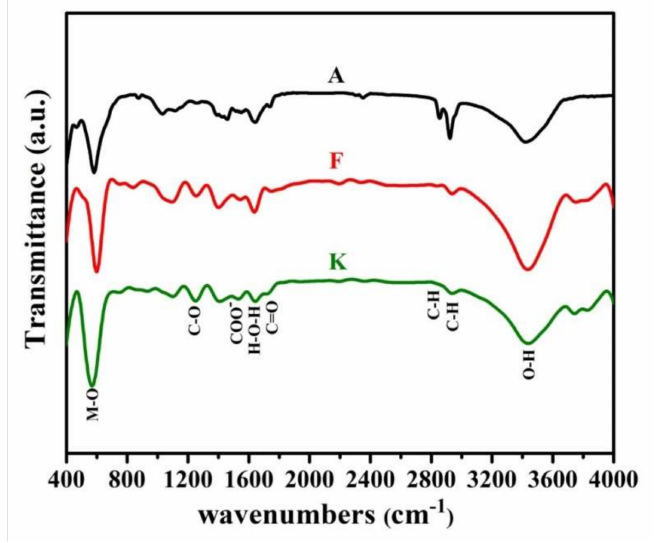
Figure 5. FT-IR spectra for the synthesized samples A, F, and